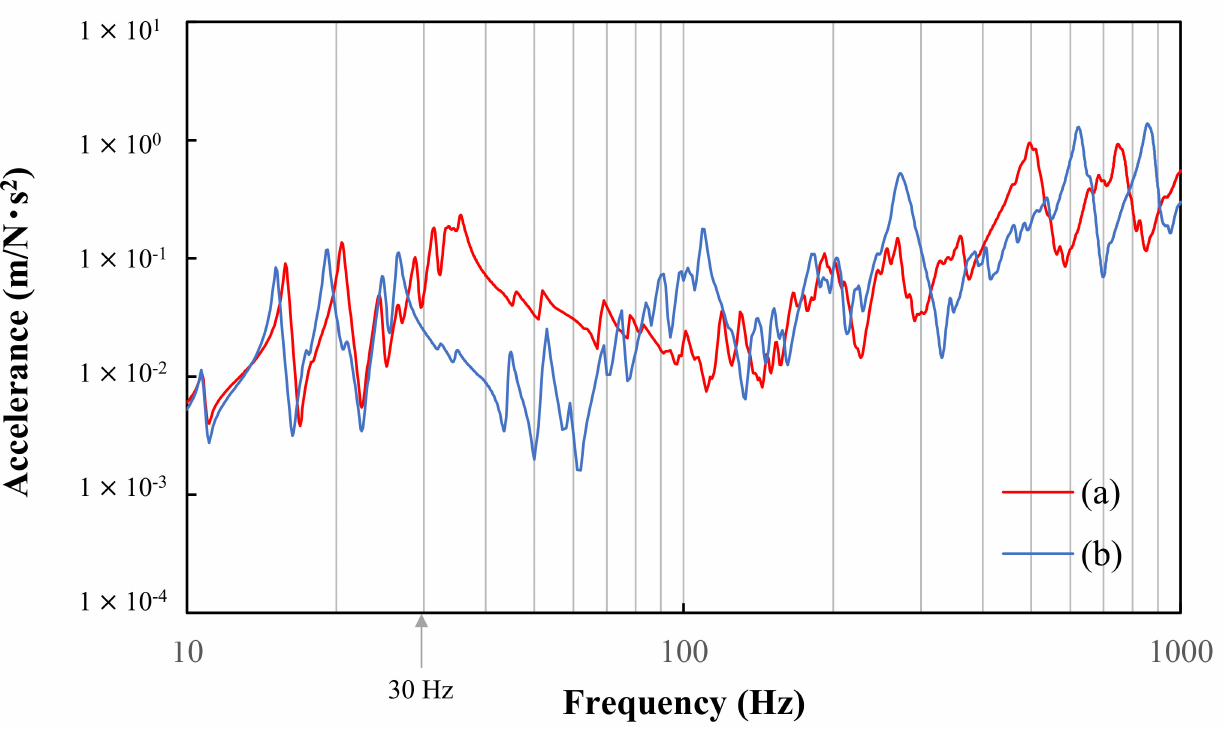
Figure 7. Effect of size of ALC floor panels on accelerance characteristics. Condition ( a ) is the numerical model with the basic-size ALC floor panels, while ( b ) is the numerical model with large ALC floor